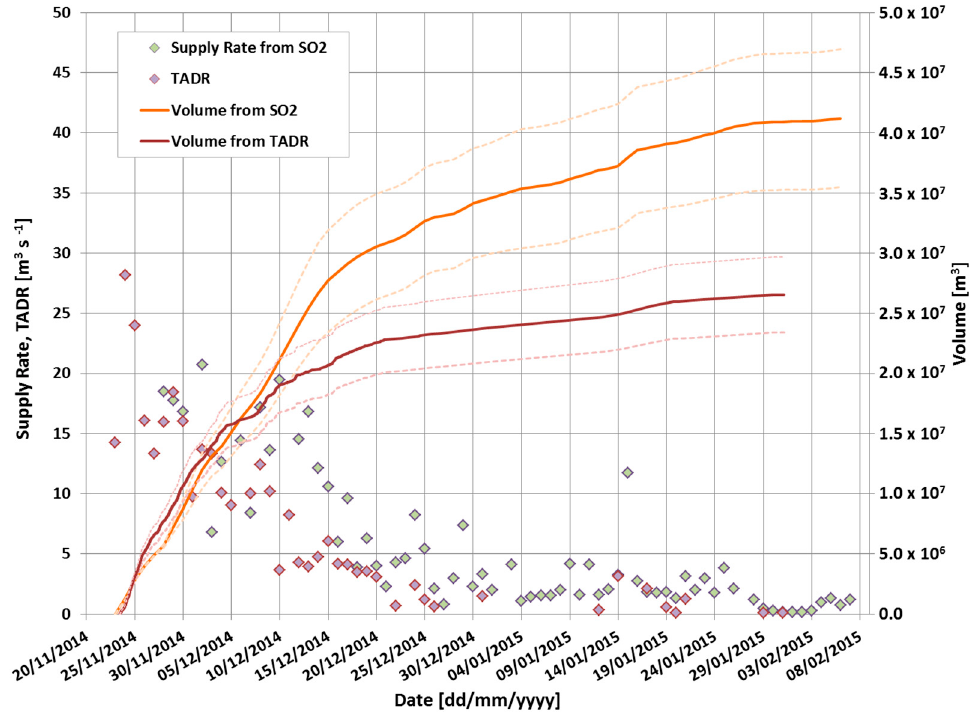
Figure 7. Graph showing Time Averaged Discharge Rate (TADR, purple diamonds) retrieved by HOTSAT and Supply Rate derived from SO 2 data (green diamonds) vs. time (dd/mm/yyyy) during the Fogo 2014–2015 effusive eruption. Red and orange solid lines and relative errors (dashed lines) show volumes obtained by integrating TADR and Supply Rate curves, respectively.